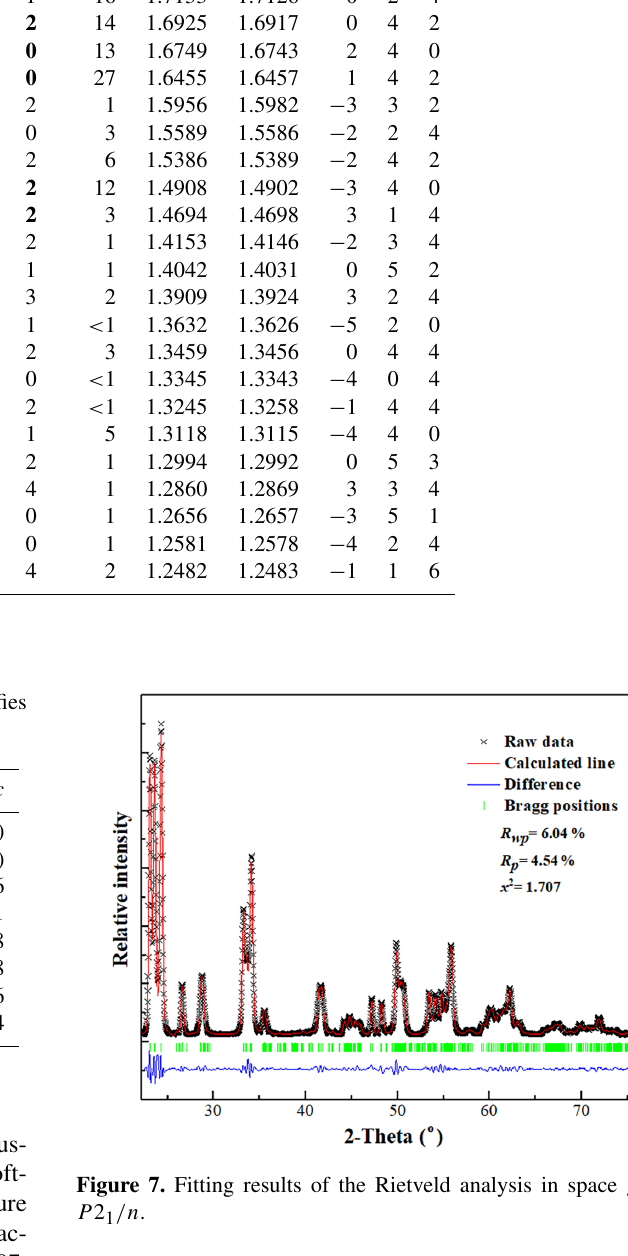
and O6 positions are 1.951, 2.074, 2.009, 2.090, 2.058, and 2.046 v.u., respectively, which are comparable to the ex- pected values. Furthermore, all of the resulting BVS values are in agreement with the ideal values (Table 5), and the re- sults meet the charge balance